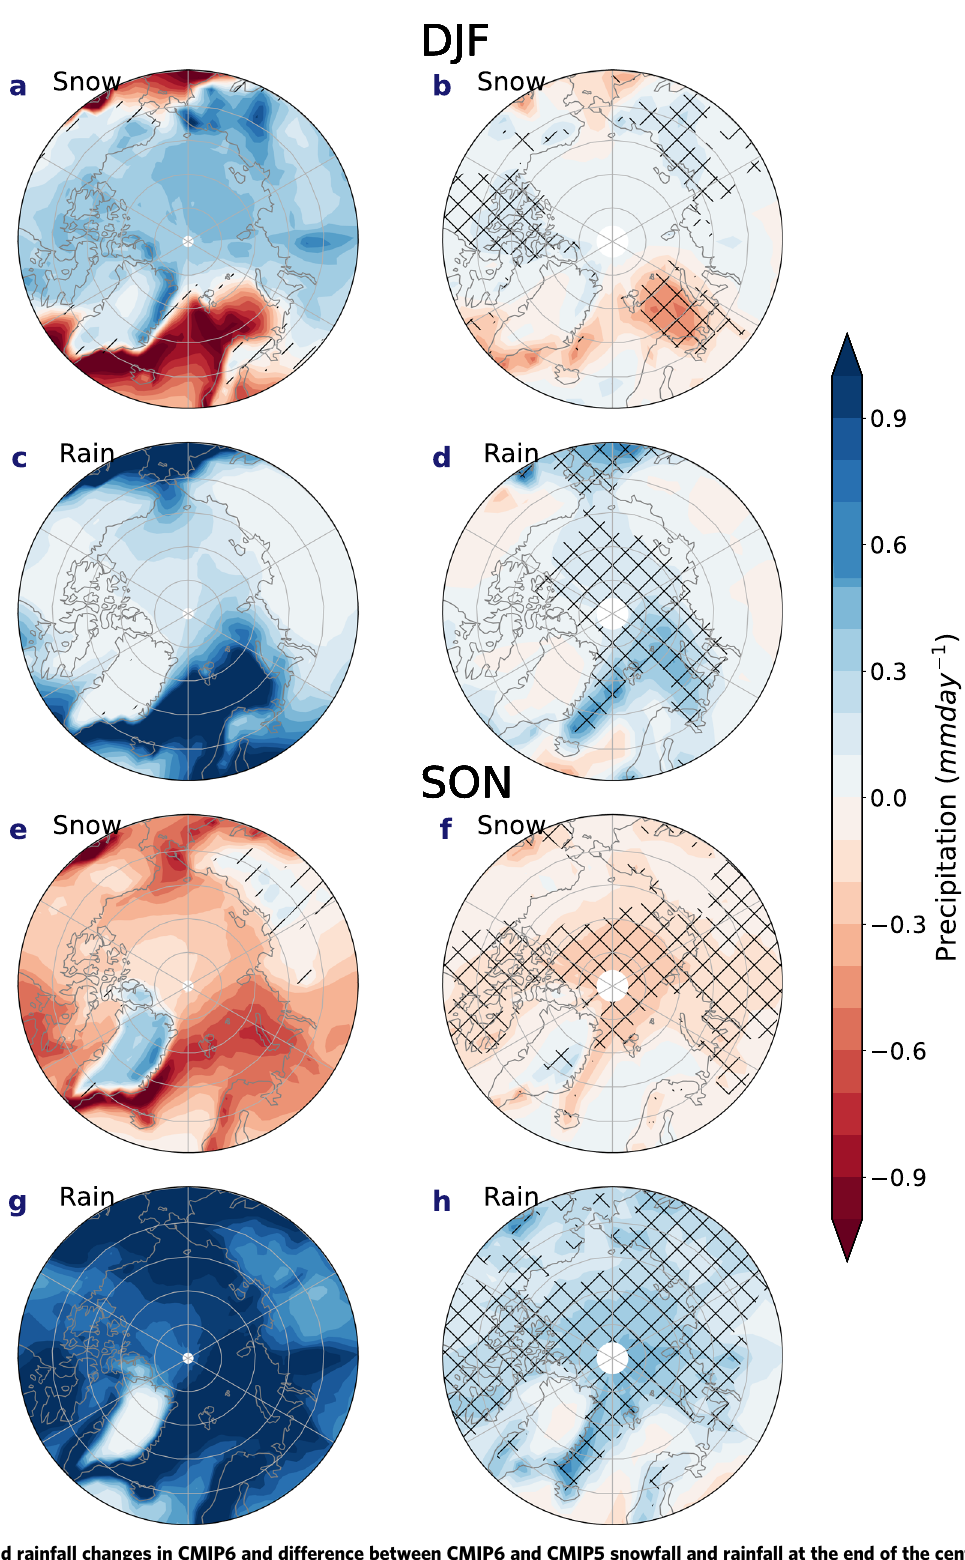
Fig. 3 Snowfall and rainfall changes in CMIP6 and difference between CMIP6 and CMIP5 snowfall and rainfall at the end of the century. The left-hand column shows the changes in a , e snowfall and c , g rainfall at the end of the century in a , c December – February (DJF) and e , g September – November (SON) in CMIP6. Straight line hatching indicates regions where differences are not statistically signi fi cant at the 95% con fi dence level. The right-hand column shows the difference in b , f snowfall and d , h rainfall at the end of the century (2091 – 2100) relative to the start of the century (2005 – 2014) between CMIP5 and CMIP6 (CMIP6 – CMIP5) for b , d December – February and f , h September – November. Hatching indicates statistical signi fi cance at 95% con fi dence